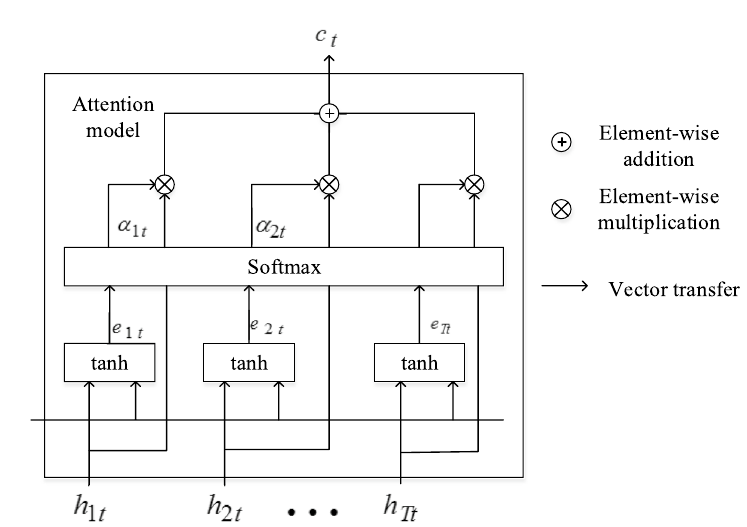
Fig. 3 Structure of attention